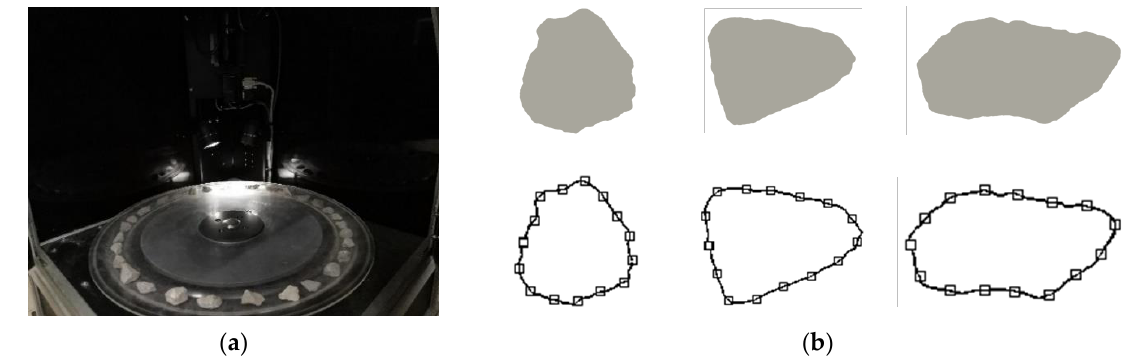
Figure 1. ( a ) Experimental setup; ( b ) instances of aggregate pictures and polygons.